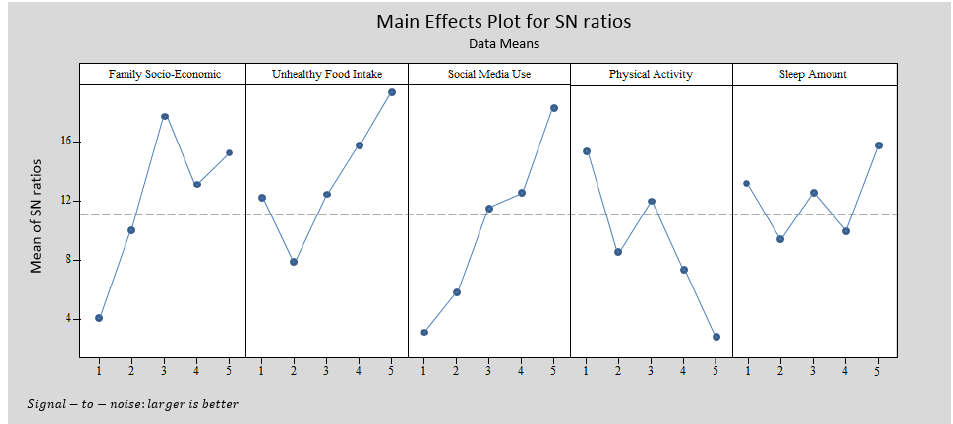
Figure 11. Taguchi output for the primary school obesity model with MINITAB software.